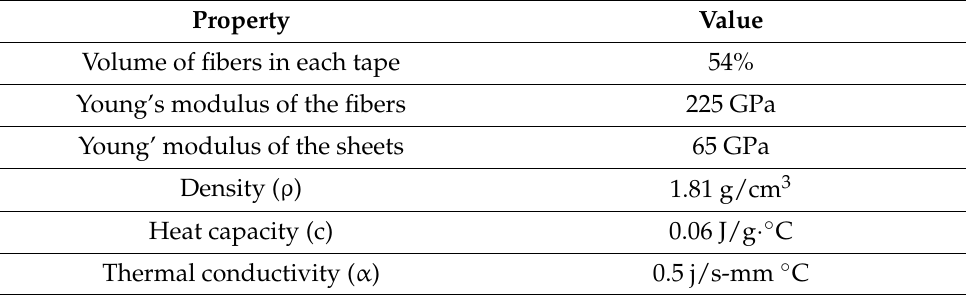
Table 2. Specifications of the tool used in the experiments. Table 1. Mechanical and physical properties of CFRP used.